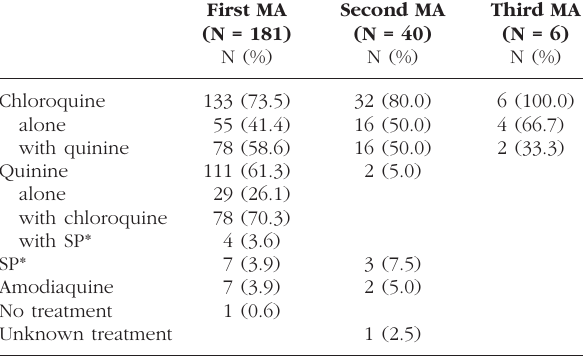
Table II. – Treatment of malaria attacks